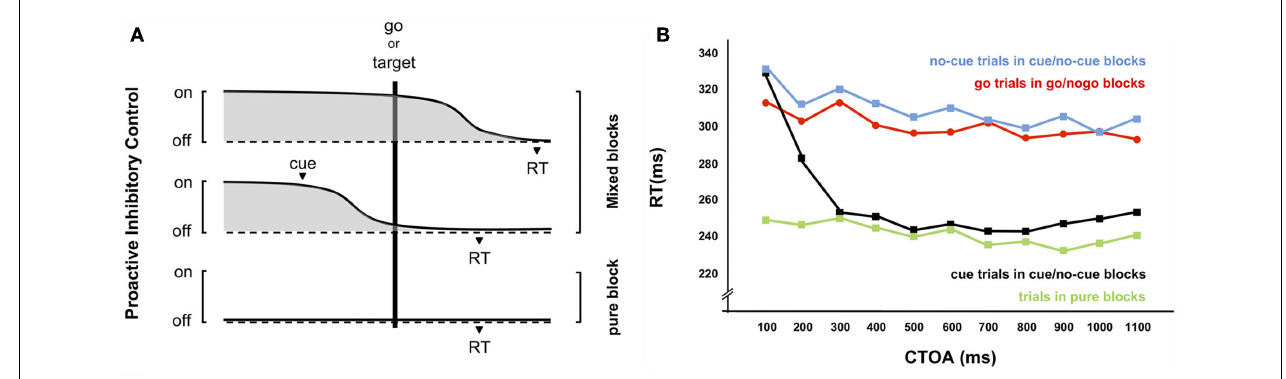
FIGURE 1 |The proactive inhibitory control model. (A) Hypothetical dynamics of proactive inhibitory control.When there is uncertainty about upcoming stimuli, as in standard mixed-block designs (e.g., go intermixed with nogo trials in go/nogo protocols – Figure2A, cue intermixed with no-cue trials in cue/target protocols – Figure 3 ), tonic response inhibition is required to prevent false alarms (automatic responses to nogo or to cue